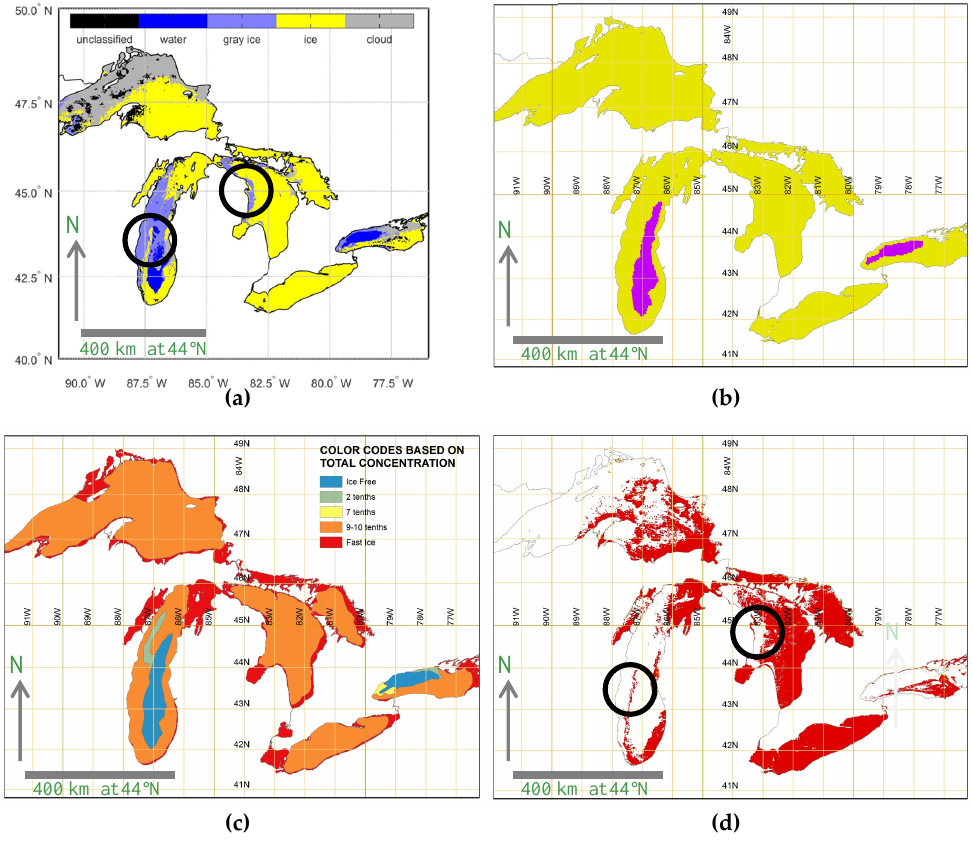
Figure 12. ( top, left ) Lake ice daily composite map; ( top, right ) IMS Snow map: white is snow, yellow Figure 12. ( a ) Lake ice daily composite map; ( b ) IMS Snow map: yellow is ice, blue is water; ( c ) is ice, blue is water; ( bottom, left ) National Ice Center ice concentration: blue is ice-free, red is fast ice; National Ice Center ice concentration: blue is ice-free, red is fast ice; ( d ) MODIS snow and ice cover: ( bottom, right ) MODIS snow and ice cover: red is more, yellow is red is more, yellow is less.